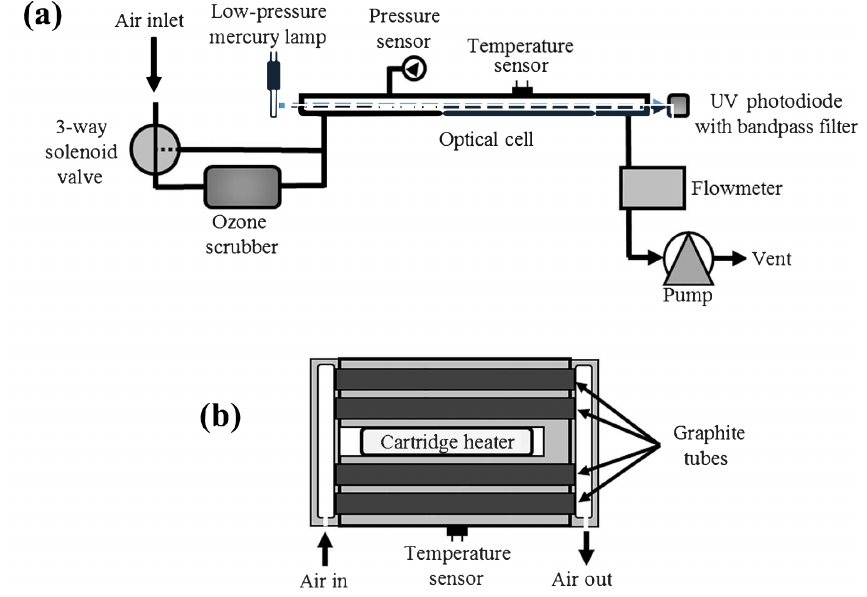
Figure 1. (a) Schematic diagram of a typical single-beam UV-absorbance monitor for ozone. (b) Schematic of the heated graphite scrubber consisting of four graphite tubes contained within a temperature-controlled aluminum